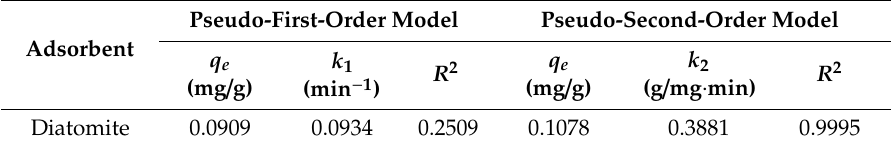
Table 2. Adsorption kinetic parameters of diatomite onto phosphorus.